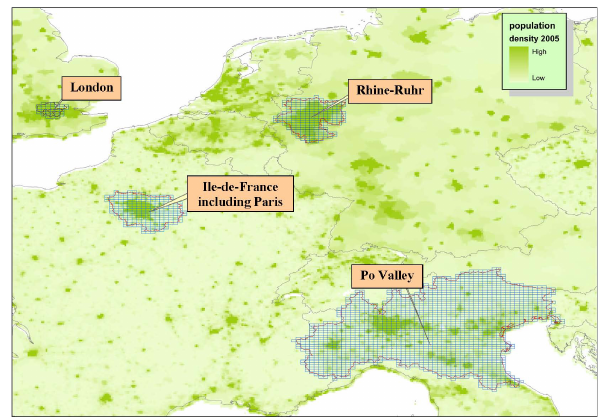
Figure 1. Domain of selected 1st level Megacities in MEGAPOLI (van der Gon et al.,